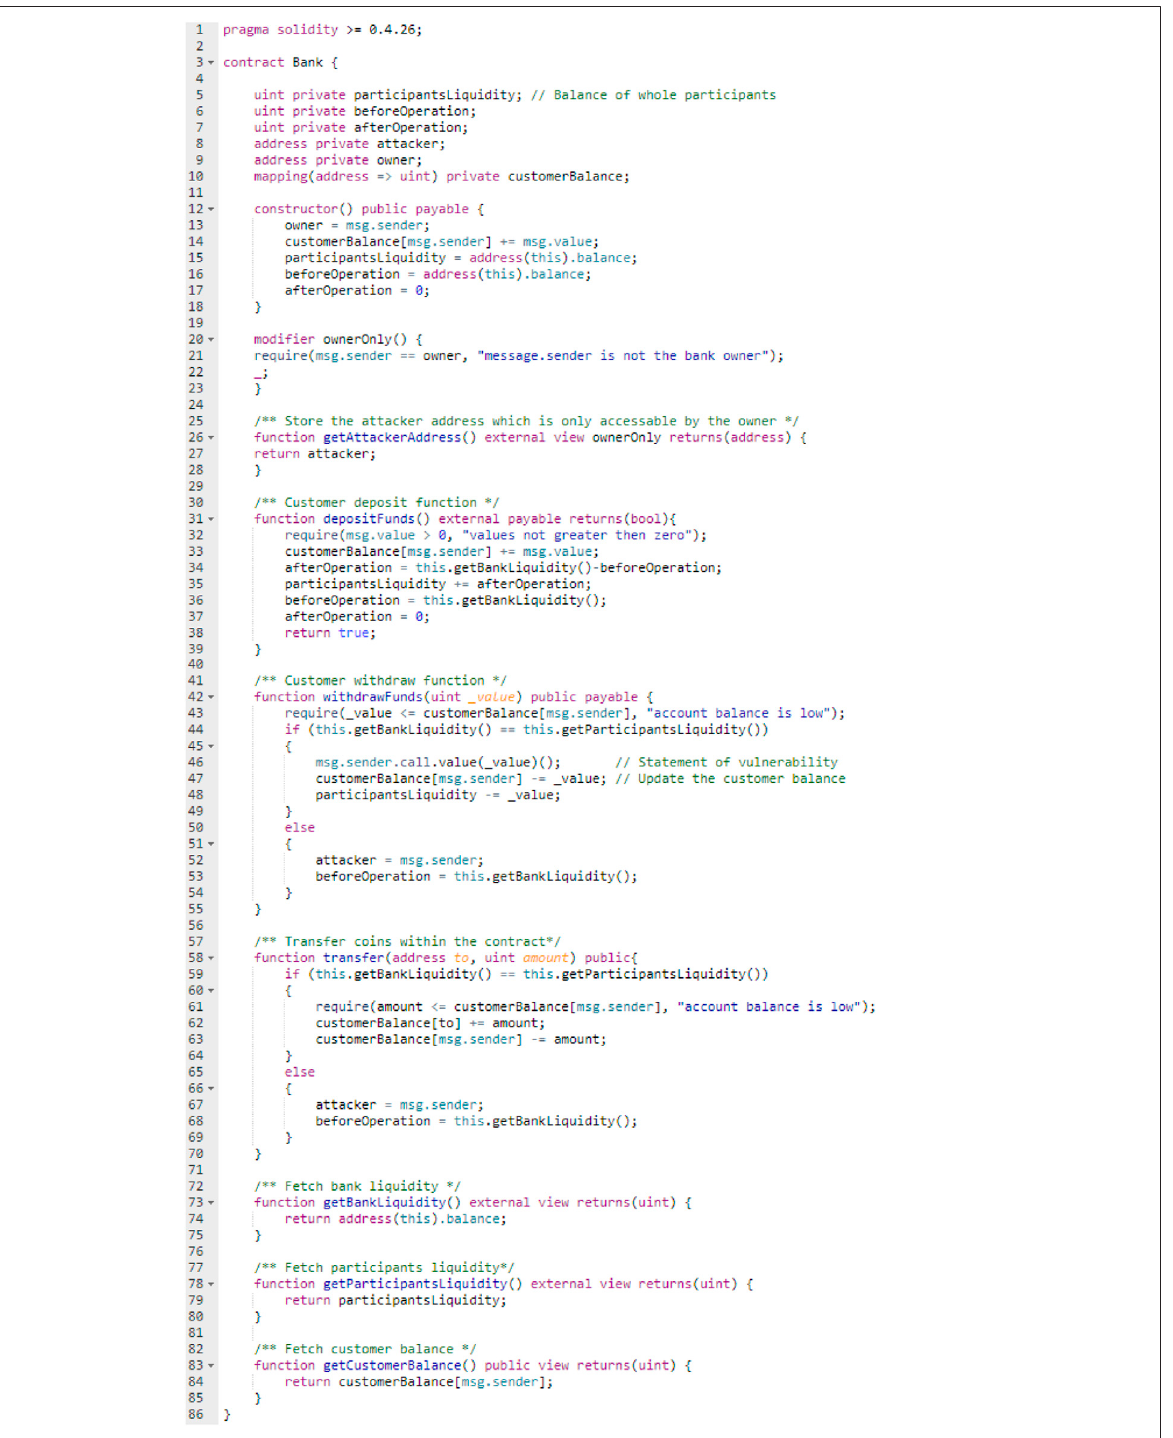
FIGURE 5 | The solution is implemented in the code of the bank smart contract.